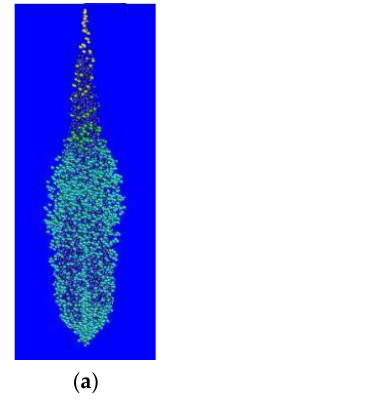
( b ) Figure 7. Comparison of the spray shape at 0.9 ms for Case 1. ( a ) Liquid- and vapor-phase spray of simulation; ( b ) Liquid- and vapor-phase spray of experiments. Case 2: A comparison of the liquid penetration lengths obtained on the basis of the simulated and experimental results are shown in Figure 8. Due to the low ambient temperature, it can be considered to be in a cold state, and the evaporation and gasification can be ig- nored. It can be seen that the simulated vapor penetration length is in good agreement with the experimental value. The relative error after 0.2 ms is within 5% of what was ex- pected for the initial spray points, and it meets the requirements of subsequent engineer- ing simulation analysis.